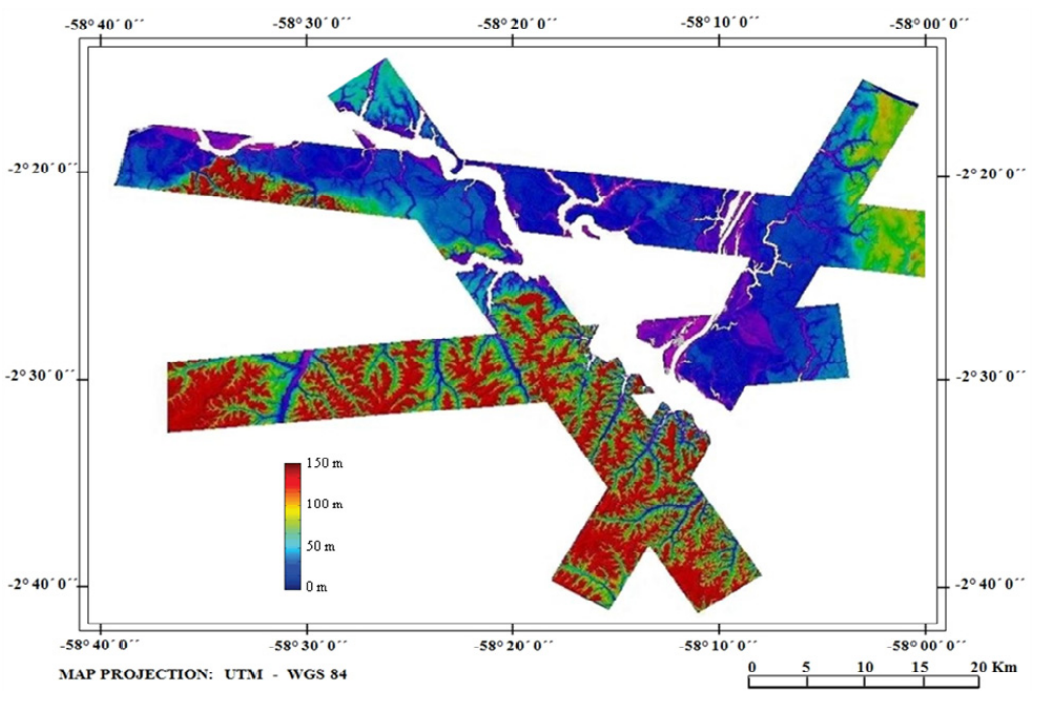
Figure 11. DEMs of OrbiSAR-1 X-band data for all tracks generated through the use of the proposed method for phase-offset estimation in the Amazon test site.